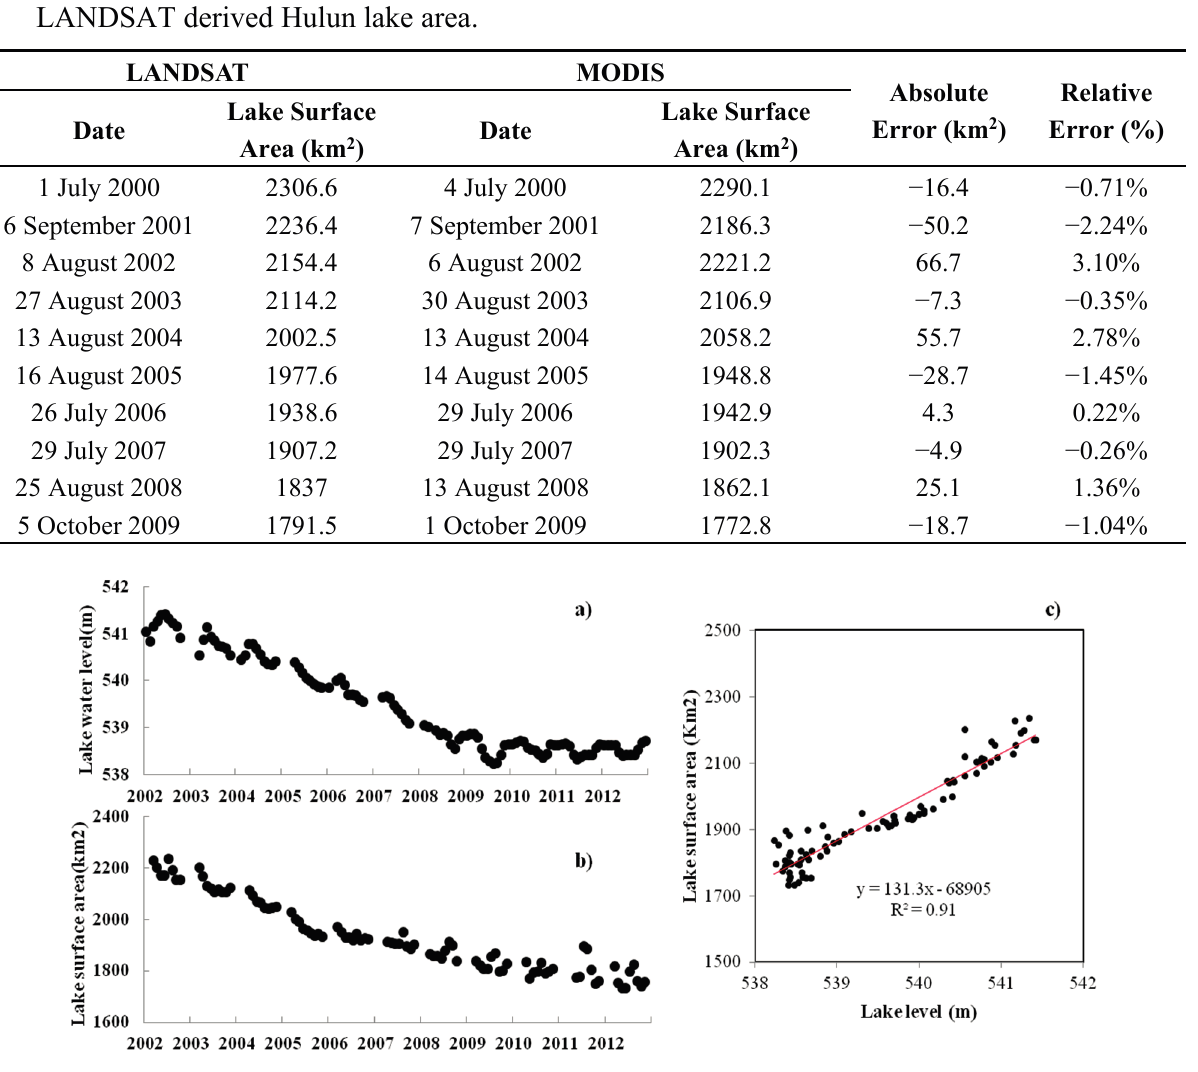
Figure 7. ( a ) Lake water level; ( b ) lake water surface area; and ( c ) correlation between lake water level and surface